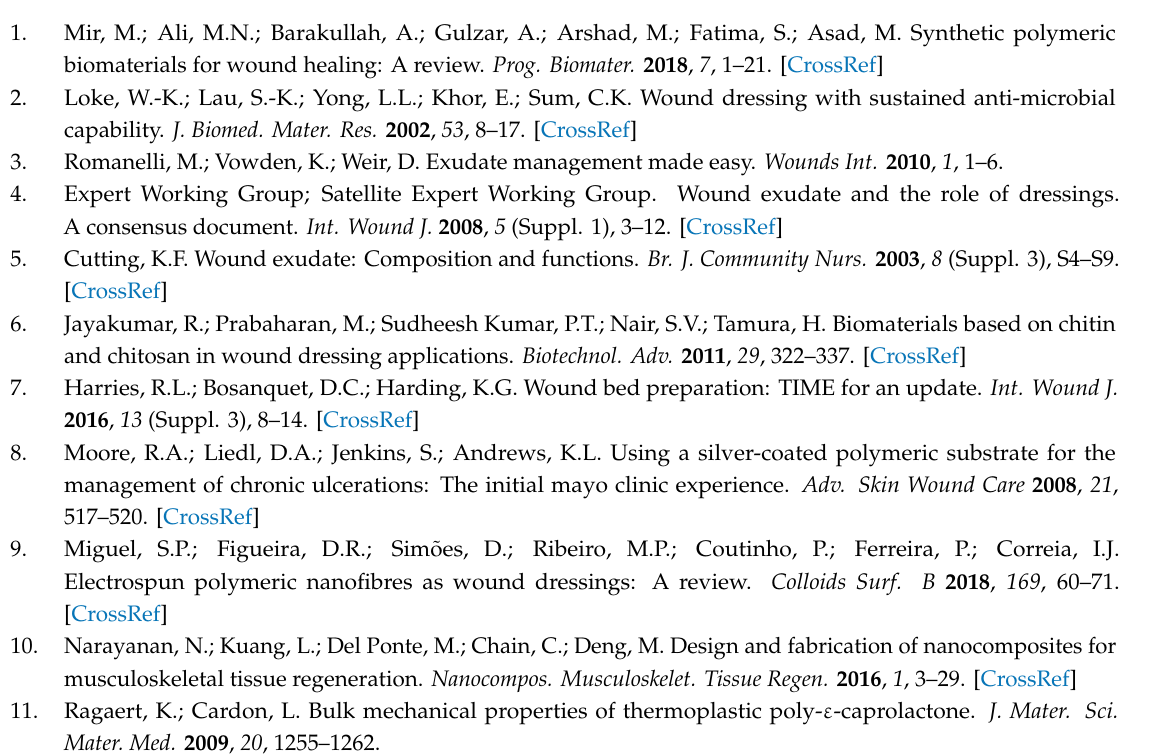
Figure S1: Average fiber diameter histograms for PCL, PVP, PCL / PVP 85:15 and PCL / PVP 95:5 microfibers, Figure S2: SEM images of PCL, PVP, PCL / PVP 85:15 and PCL / PVP 95:5 microfibers sca ff olds, Figure S3: Di ff erential Scanning Calorimetry thermograms of electrospun fibers produced with PCL, PVP and PCL / PVP 95:5 and 85:15 ratio, Figure S4: PCL, PVP and PCL / PVP fibers dissolution test, Figure S5: Percentage of microbial, Table S1: Percentage of microbial